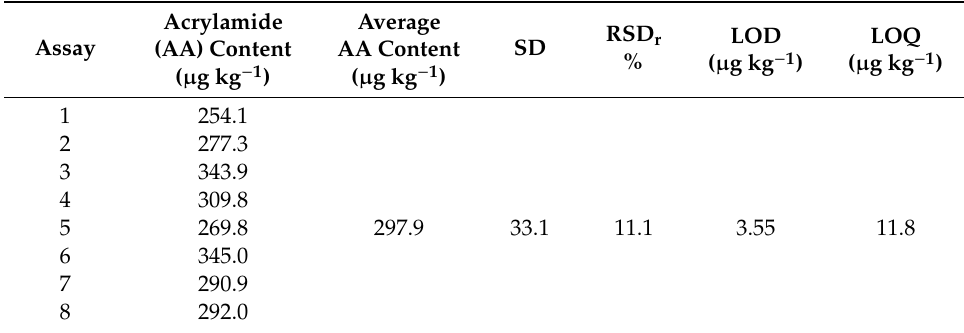
Table 1. Repeatability, limit of detection (LOD), and limit of quantification (LOQ) of the proposed methodology, based on several measurements of Biscuit